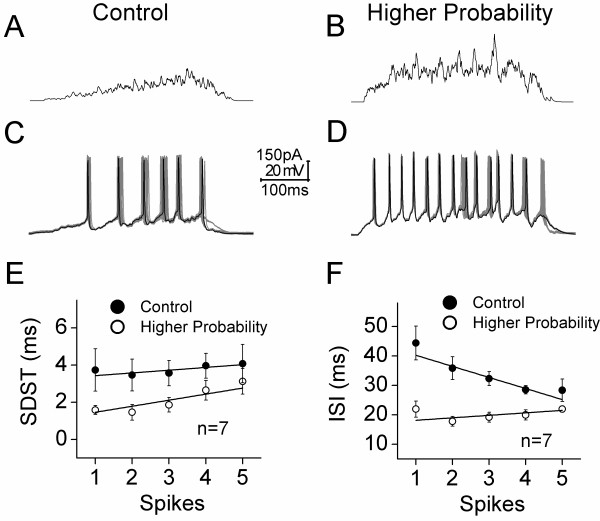
Higher release probability during sequential presynaptic spikes enhances the capacity and precision of spike encodings at postsynaptic GABAergic neurons. A-B) show the integrated signals from unitary glutamatergic synapses under the conditions of control (A) and adenophostin-A infusion (B, higher probability). C-D) illustrate spike patterns induced by the integrated signals from unitary glutamatergic synapses under the conditions of control (C) and AD infusion (D, higher probability) G) shows the comparisons of standard deviation of spike timing (SDST) vs. spikes under the conditions of control (filled symbols) and AD infusion (higher probability, opened symbols; n = 7). H) illustrates the comparisons of inter-spike intervals (ISI) vs. spikes under the conditions of control (filled symbols) and AD infusion (higher probability, opened symbols; n = 7). Calibration bars are 150 pA, 20 mV and 100 ms. Lines in E ~ F illustrate linear dynamical fitting.